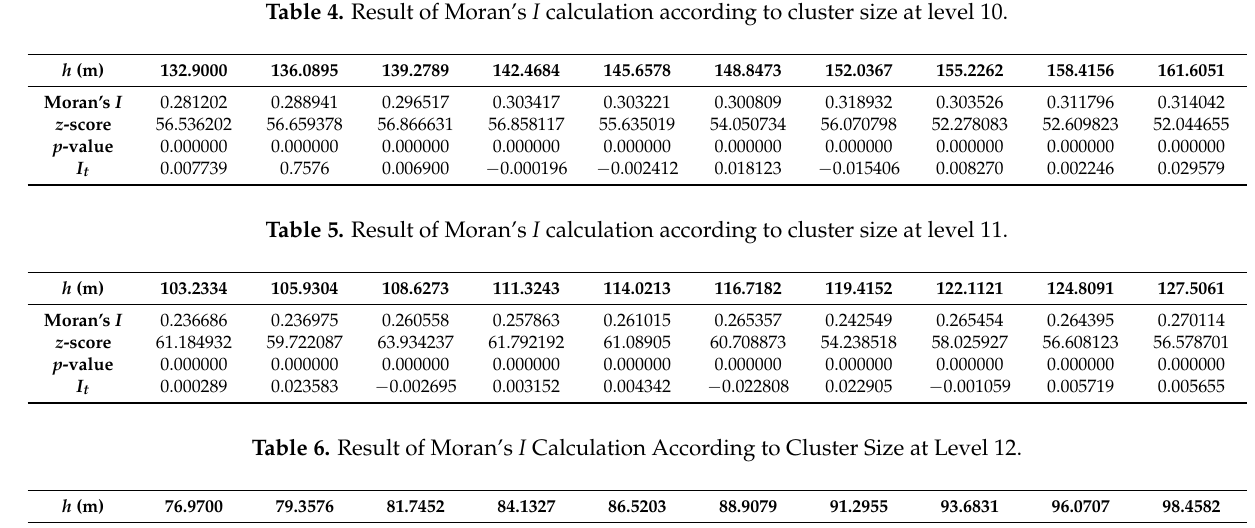
Table 4. Result of Moran’s I calculation according to cluster size at level 10.